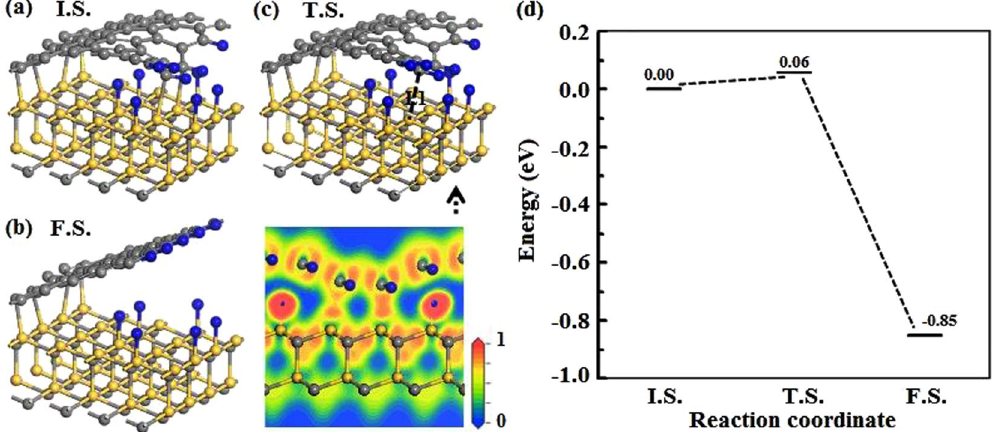
Figure 6. Migration pathway ( a , b , c ) and energy barrier ( d ) for the graphene edge decoupling from the SiC (0001) surface. ( a ) and ( b ) Are the initial state (I.S.) and final state (F.S.). ( c ) Is the atomic structure and ELF of the transition state